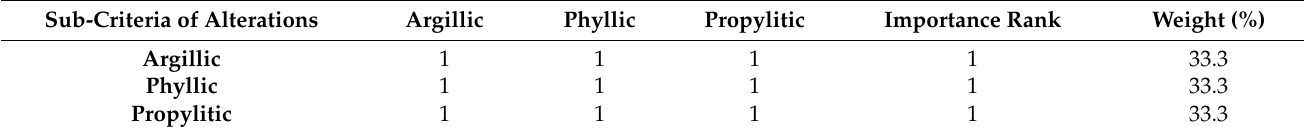
Table 11. Paired comparison matrix and calculated weights for sub-criteria of alterations criteria by AHP method.